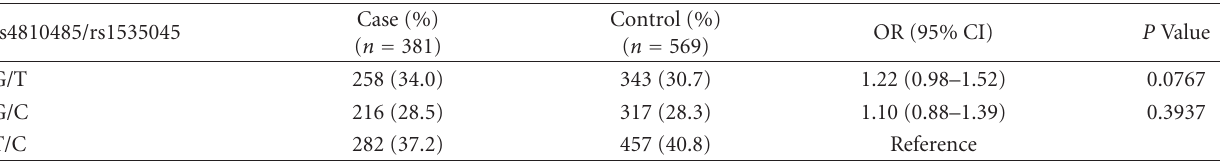
Table 4: Haplotype frequencies of the CD40 gene in controls and patients with Kawasaki